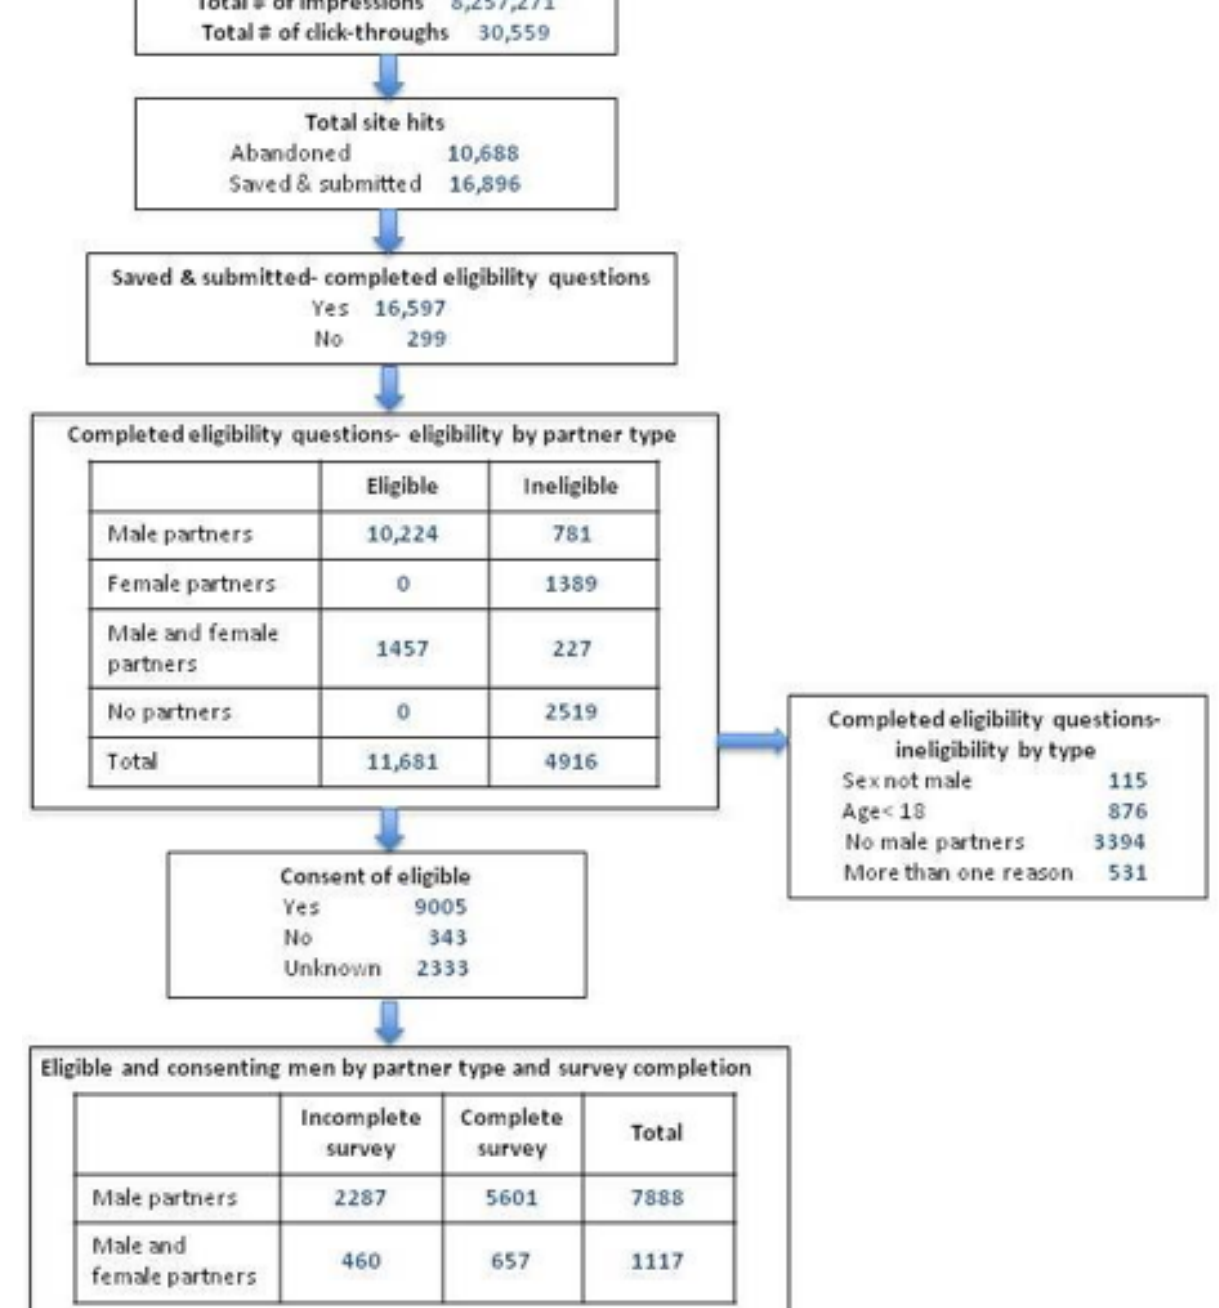
Figure 2. Flow chart of participant recruitment, eligibility, and enrollment in an online HIV behavioral risk study conducted in the United States